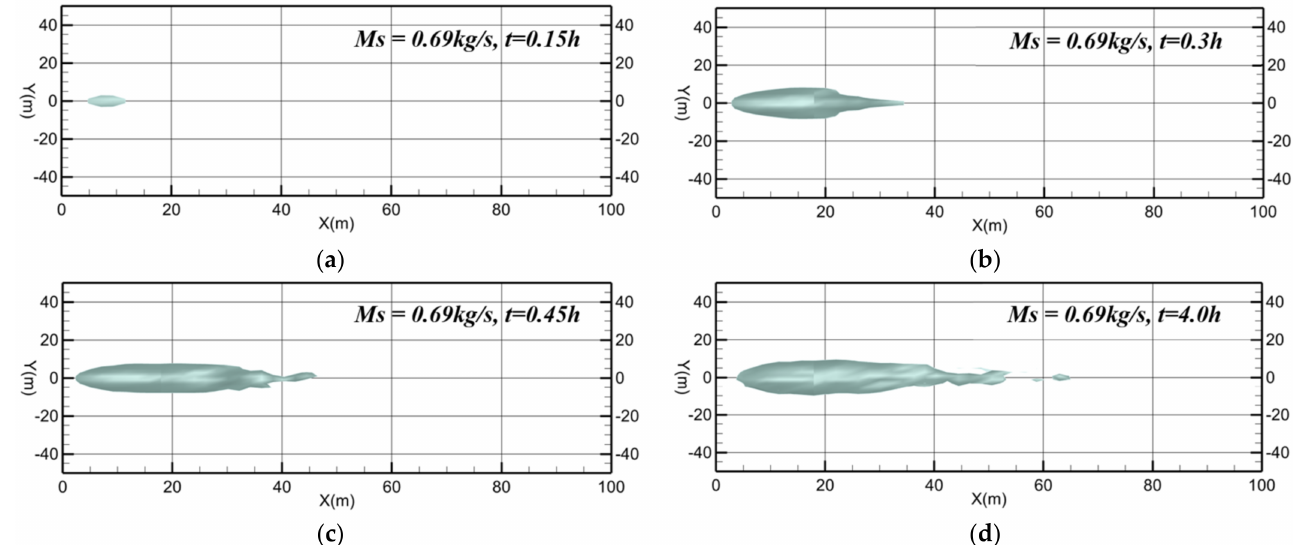
Figure 7. Temporal evolution of the sub-plume with an iso-surface of 180 mg/L during the discharg- ing at the rate of 0.69 kg/s. ( a ) t = 0.15 h, ( b ) t = 0.3 h, ( c ) t = 0.45 h, and ( d ) t = 4 h.